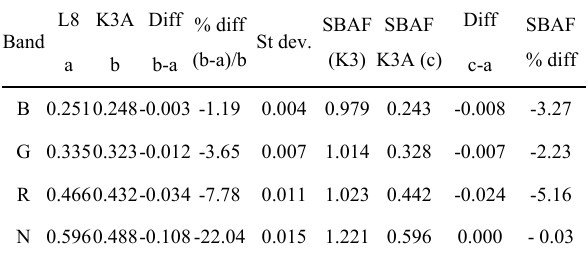
Table 4. Apply SBAF for 07/27 Cross calibration